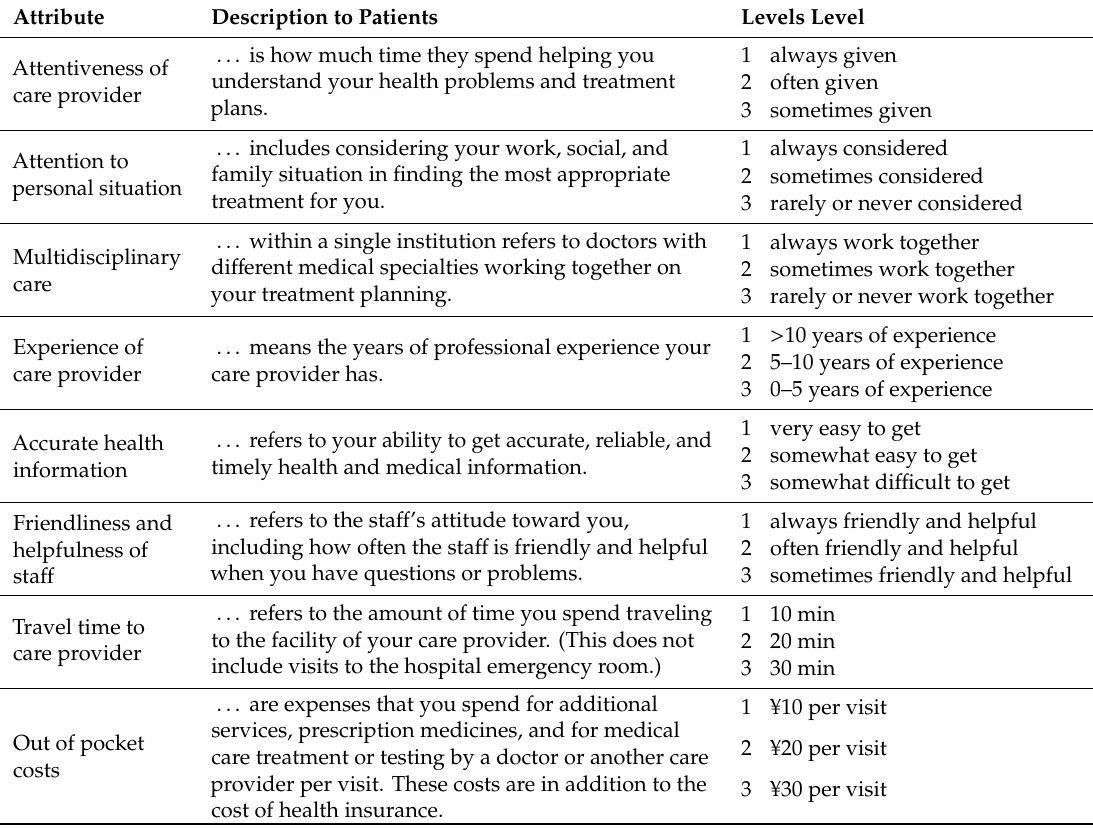
Table 1. Attributes and levels used in the discrete choice